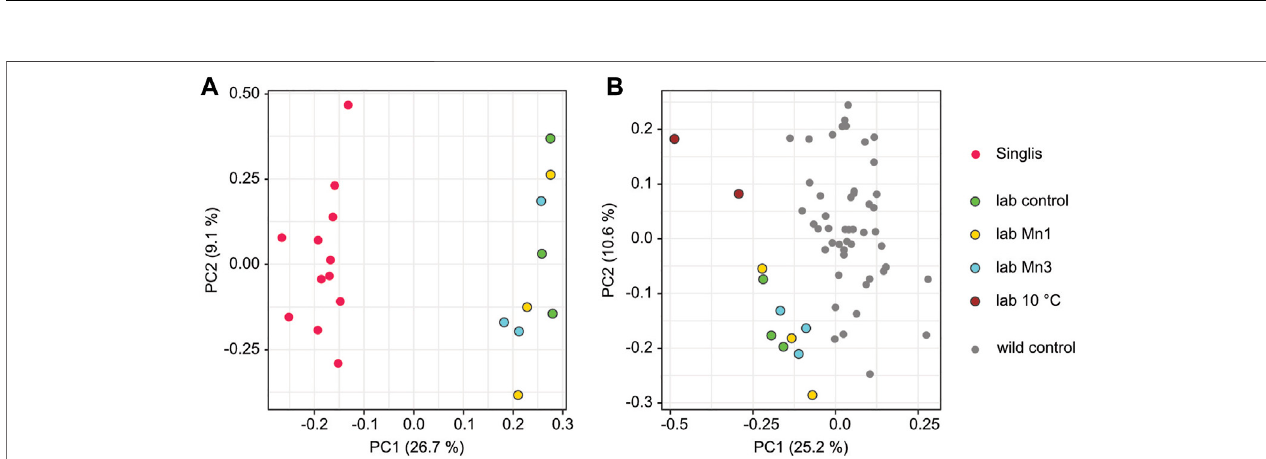
FIGURE6| Experimental modelingofcontext-dependentmethylationsignatures. Allsamplesforthisanalysisweretakenfromthehepatopancreas6 monthsafter thestartoftheexperiment.Conditionsaredisplayedincolors:green,control;darkred,10 ° C;yellow,manganese1 mg/L(Mn1);blue,manganese3 mg/L(Mn3). (A) PCA based on the average methylation ofthe core set of 361 variably methylated genes, showing the separation of individual samples from Singliser See (red) and laboratory animals (green, yellow, and blue). (B) PCA based on the average methylation of the core set of 361variably methylated genes, showing the separation ofindividual wild animals (gray) from laboratory animals (dark red, green, yellow, blue) and the separation of animals kept at low temperature (10 ° C, dark red) from other laboratory animals (green, yellow, blue).